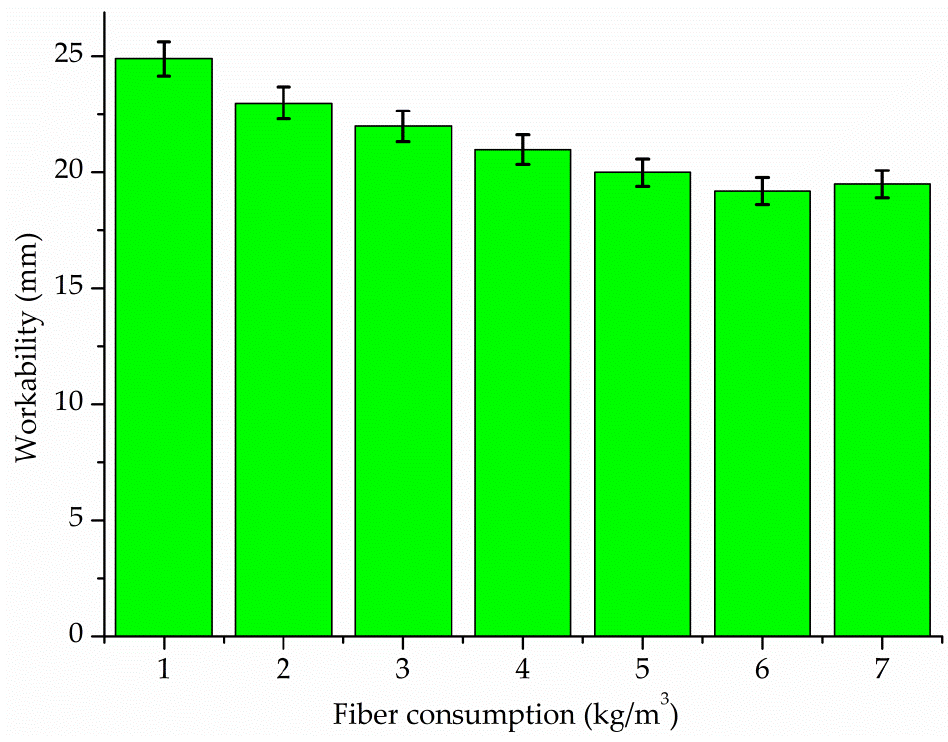
Figure 6. Influence of untreated fiber content on workability of concrete mixture.